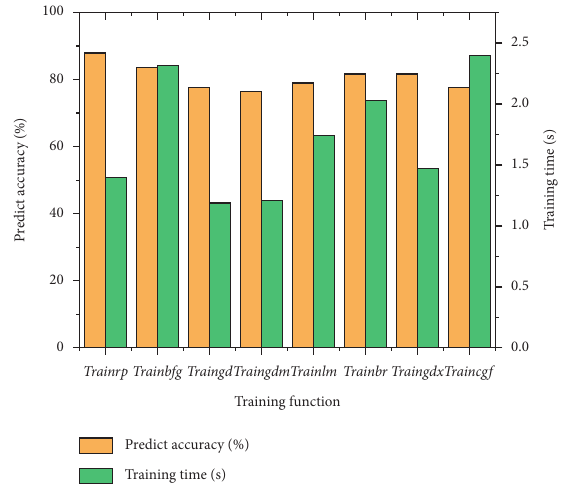
Figure 7: Prediction accuracy and training time of the